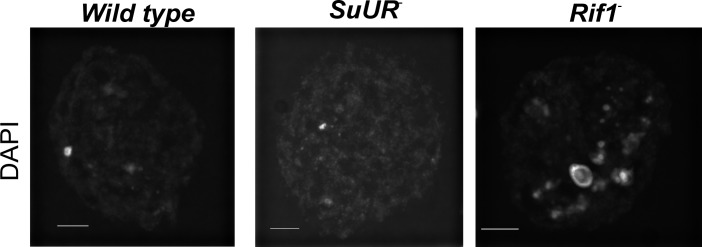
Rif1 mutant endo cycling cells have enlarged chromocenters.Representative images of single nurse cell nuclei from stage 10 egg chambers. Egg chambers were stained with DAPI. Scale bar is 10 μm. Exposure times and scaling are equal in all images.